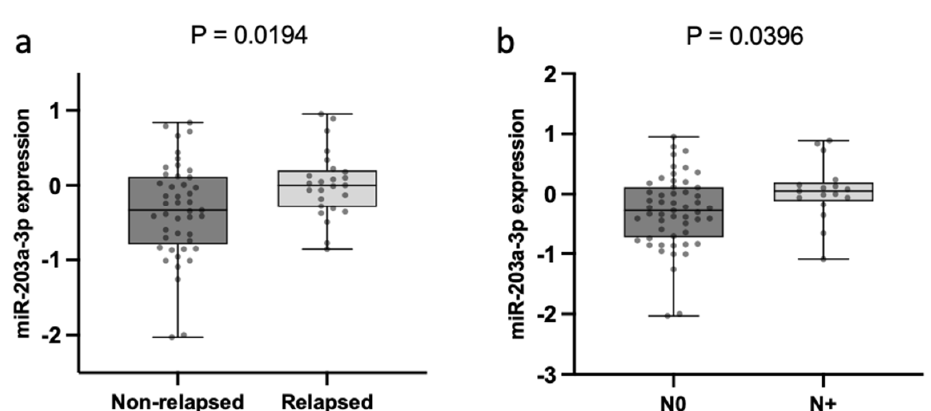
Figure 6. TDV EV-miR-203a-3p expression and clinical variables: ( a ) Boxplot showing EV-miR-203a-3p levels in non-relapsed and relapsed patients. ( b ) Boxplot showing expression levels in N0 vs. N+ patients.